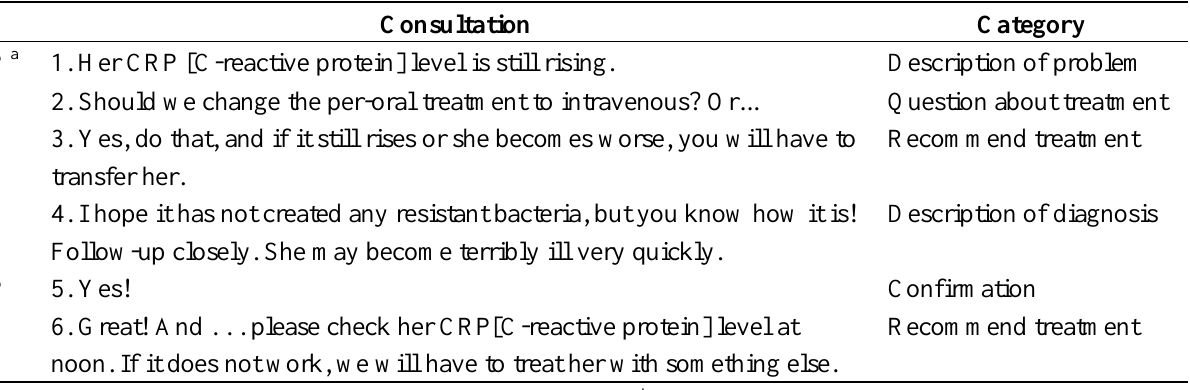
Table 2. The medical talk in consultation between levels of